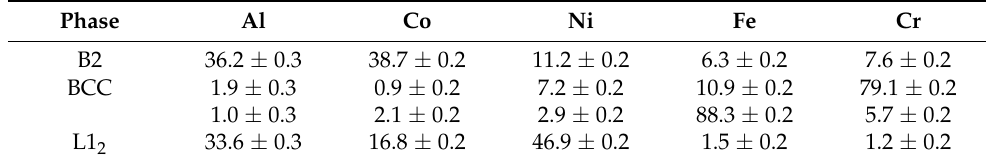
Table 2. Chemical analysis of different phases after CS.